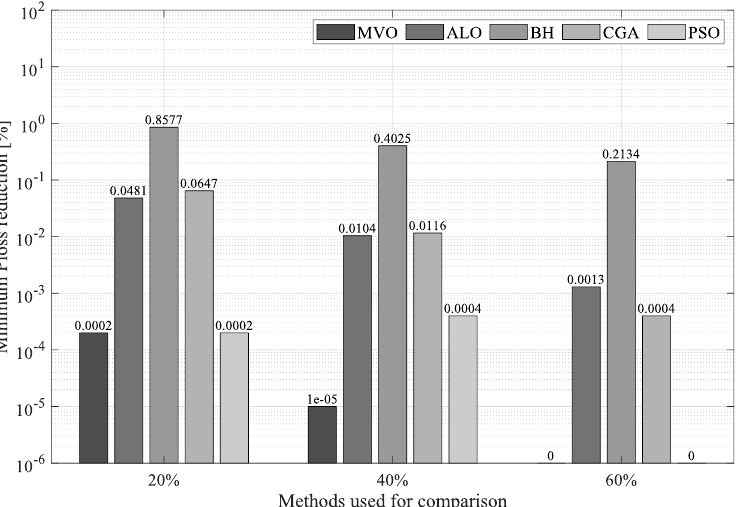
Figure 8. Percentage of reduction in minimum power losses obtained by the SSA in the 69-node system compared to that of the other